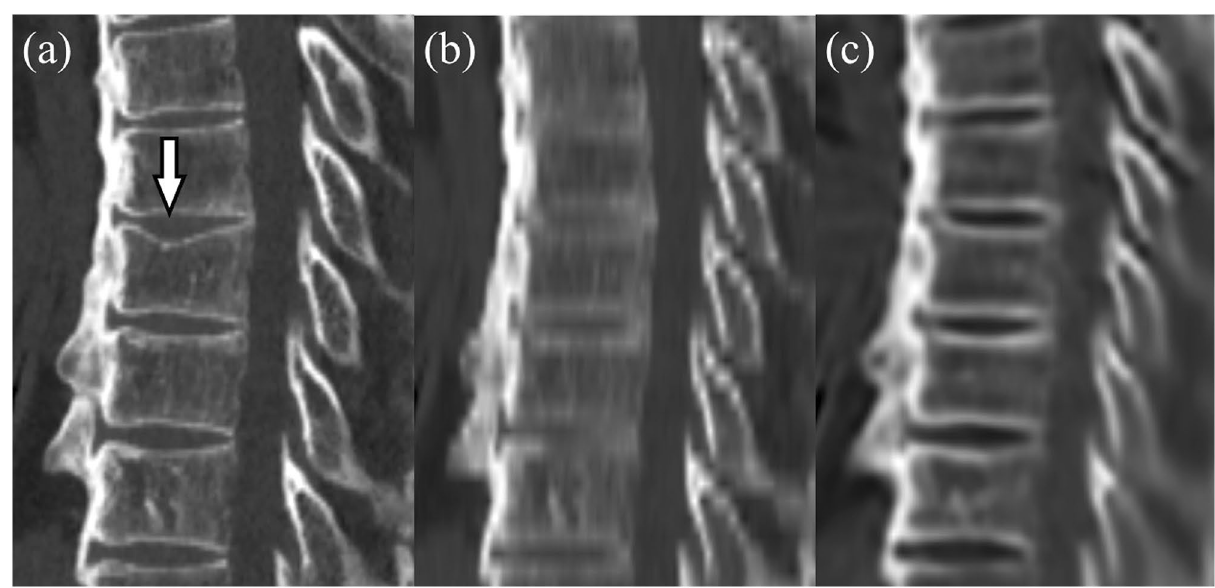
Figure 3. Sagittal reformatted images reconstructed from 1-mm-thick images ( a ), 4-mm-thick images ( b ), and virtual thin-slice images ( c ). A compression fracture of the 8th thoracic vertebra is seen on the reconstruction from 1-mm-thick images (arrow), but is not depicted on that from virtual thin-slice